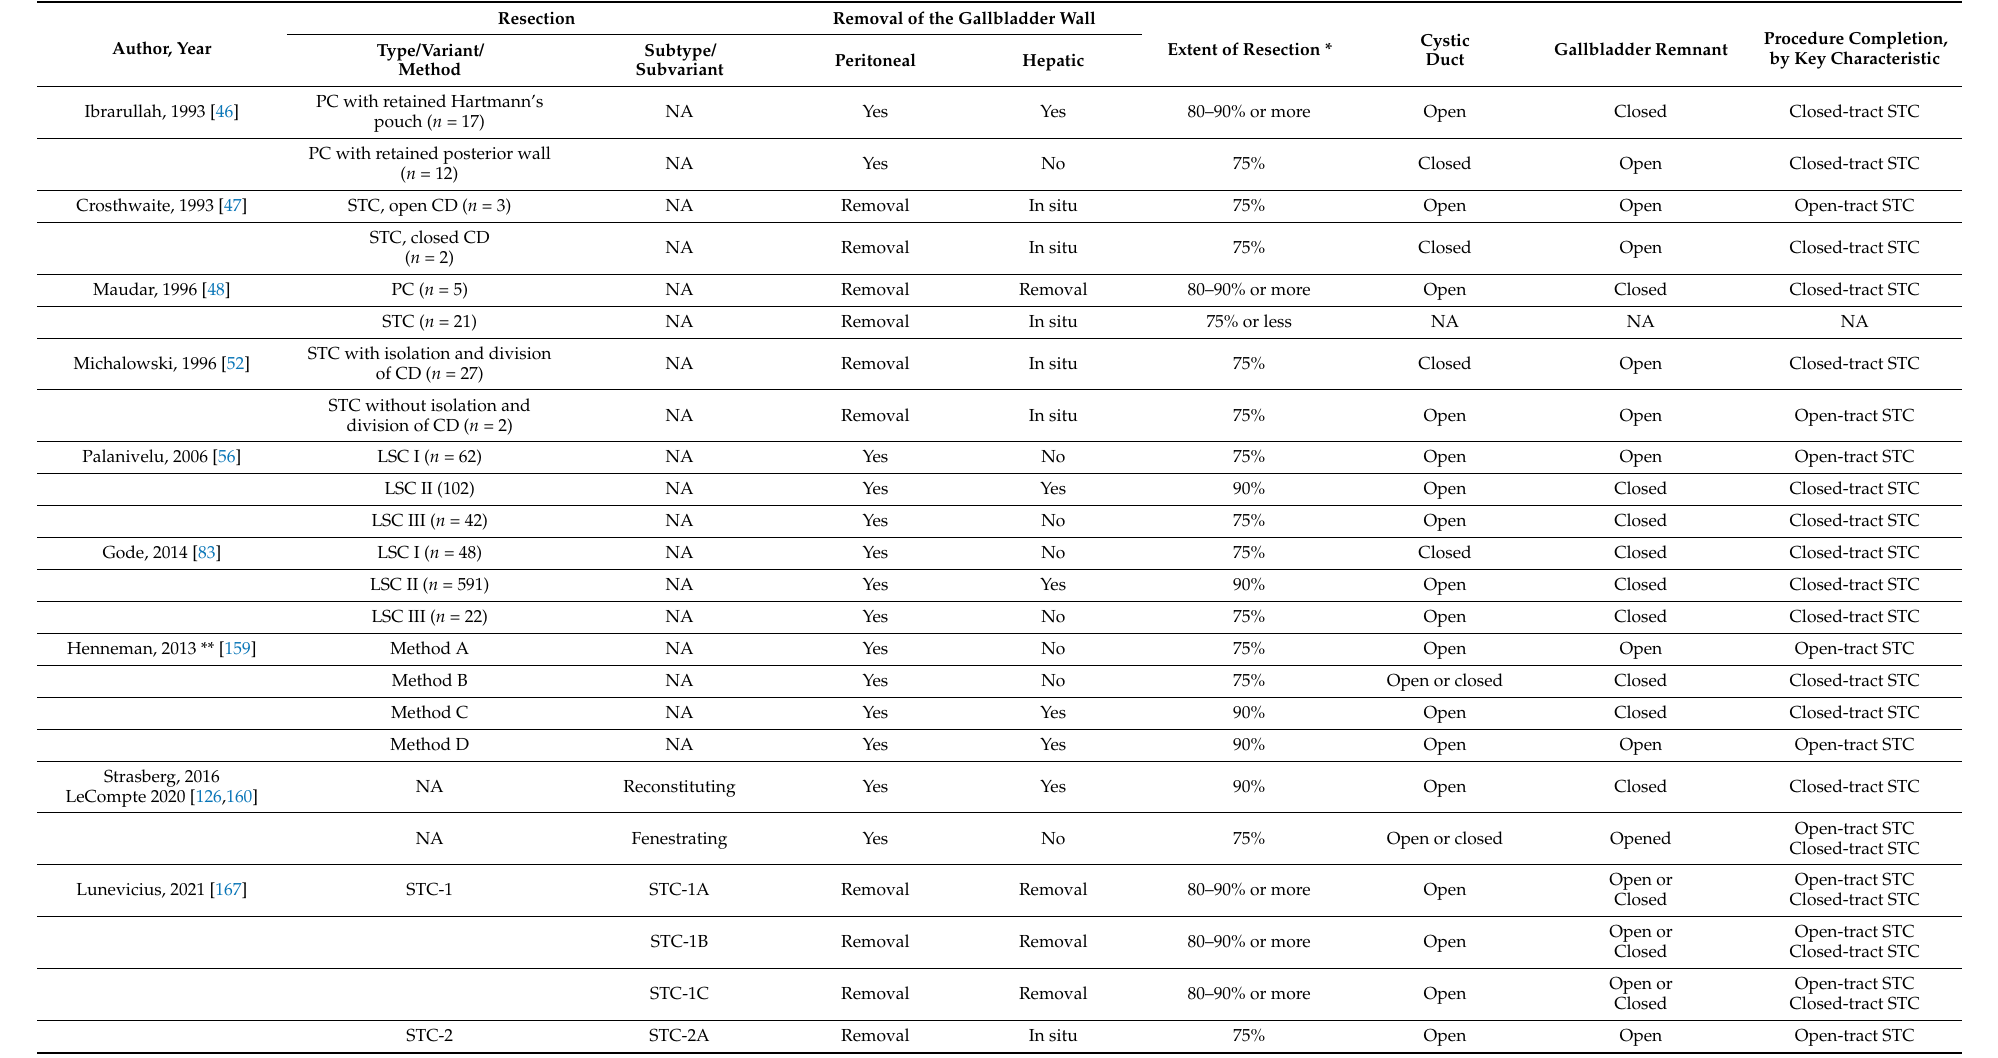
Table 1. The systematisation of partial resections of the gallbladder, by the individual article: types, variants, methods, and procedure